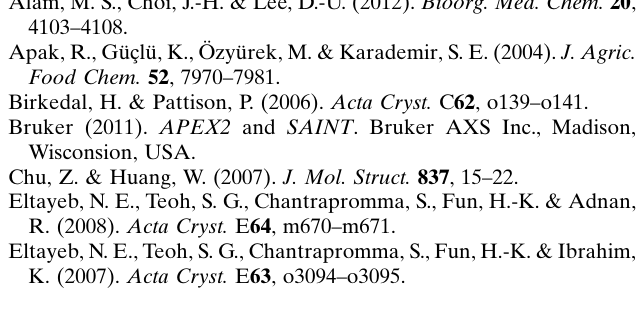
Table 3 Experimental